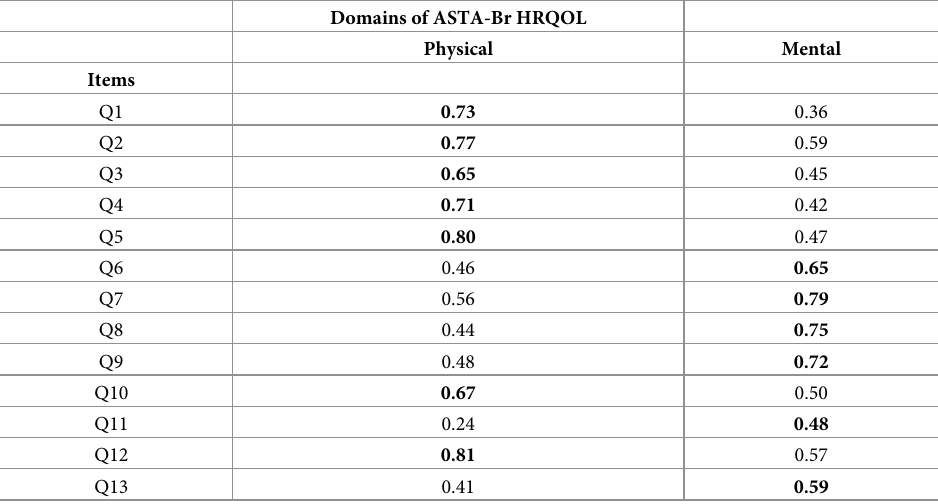
Bold values: factor load values of the items in the domains in which they were previously allocated. ASTA-Br HRQOL = the Arrhythmia-Specific Questionnaire in Tachycardia and Arrhythmia—Brazilian version- health-related quality of life scale.